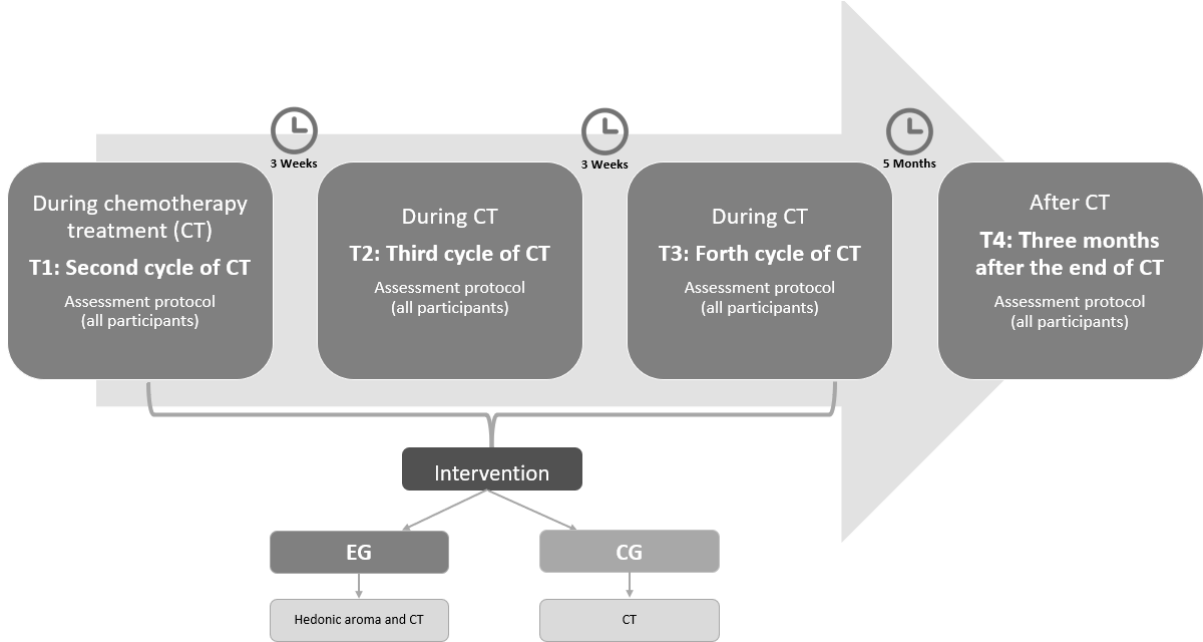
Figure 2. Intervention